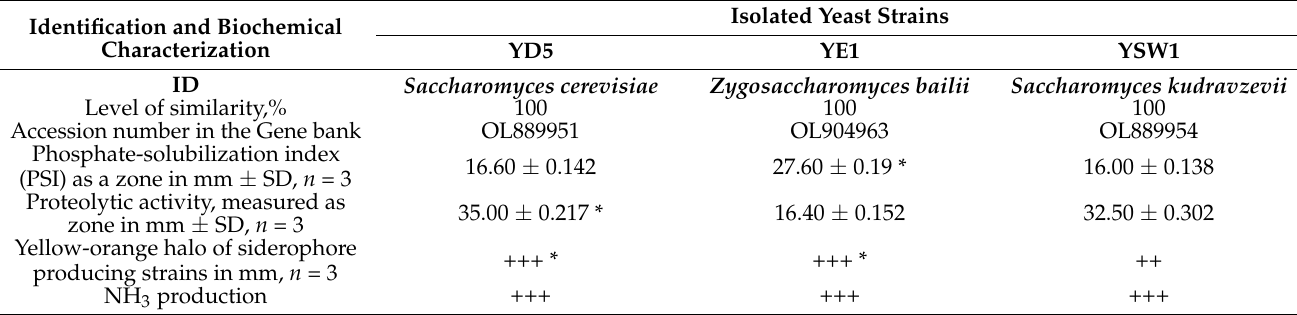
Table 1. Identification and biochemical characterization of isolated